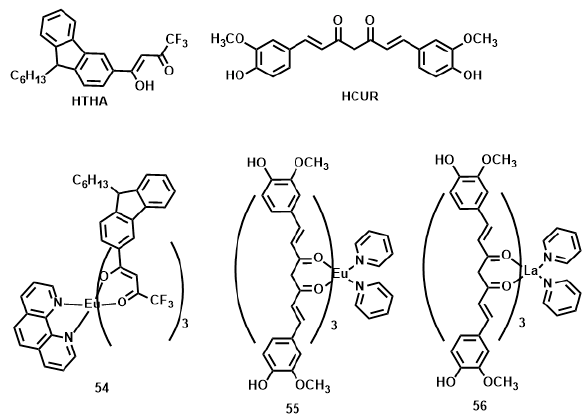
Figure 11. The structures of ligands HTHA (4,4,4-trifluoro-1-(9-hexylcarbazole-3-yl)-1,3-butanedione) and HCUR (1,7-bis(4-hydroxy-3-methoxyphenyl)-1,6-heptadiene-3,5-dione) and its rare earth complexes 54 – 56 .